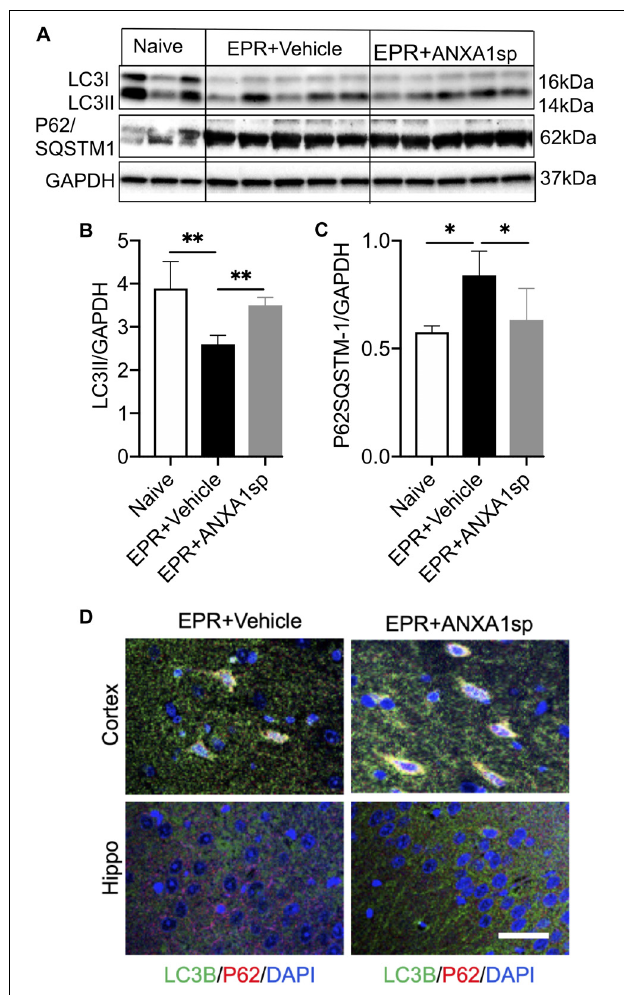
FIGURE 7 | ANXA1sp promotes cerebral autophagy after exsanguinating cardiac arrest/EPR. The expression of LC3II and p62/SQSTM1 (sequestosome 1) was assessed by western blot and normalized to GAPDH (A–C) . (D) Colocalization of LC3B with p62 in cortical and hippocampal slides from animals treated with ANXA1sp and vehicle (controls) was visualized by double immunofluorescence staining and confocal microscopy. Increased number of LC3B positive/p62 positive puncta appears in the ANXA1sp-treated group. ∗∗ p < 0.01; ∗ p < 0.05.